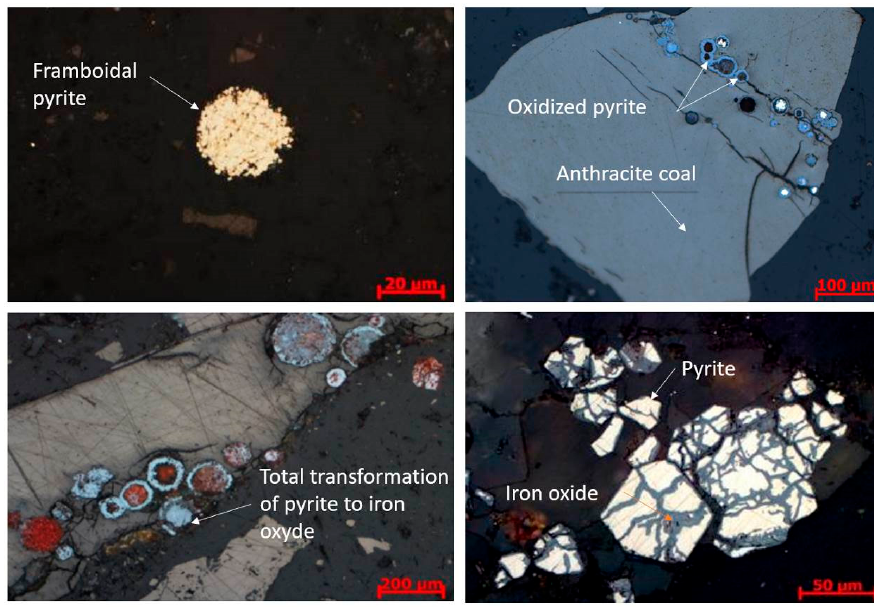
Figure 3. Optical microscopy observations of CMWR sample.